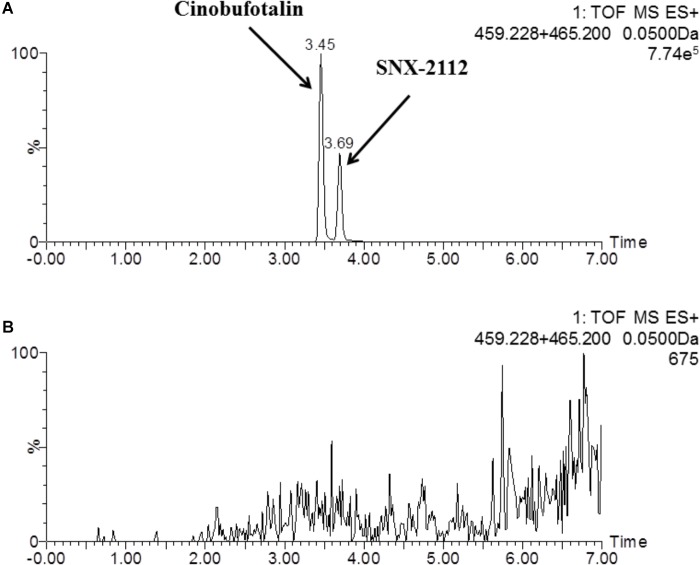
Representative mass chromatograms of spiked cinobufotalin and SNX-2112 (IS) in rat plasma (A), and blank rat plasma (B).